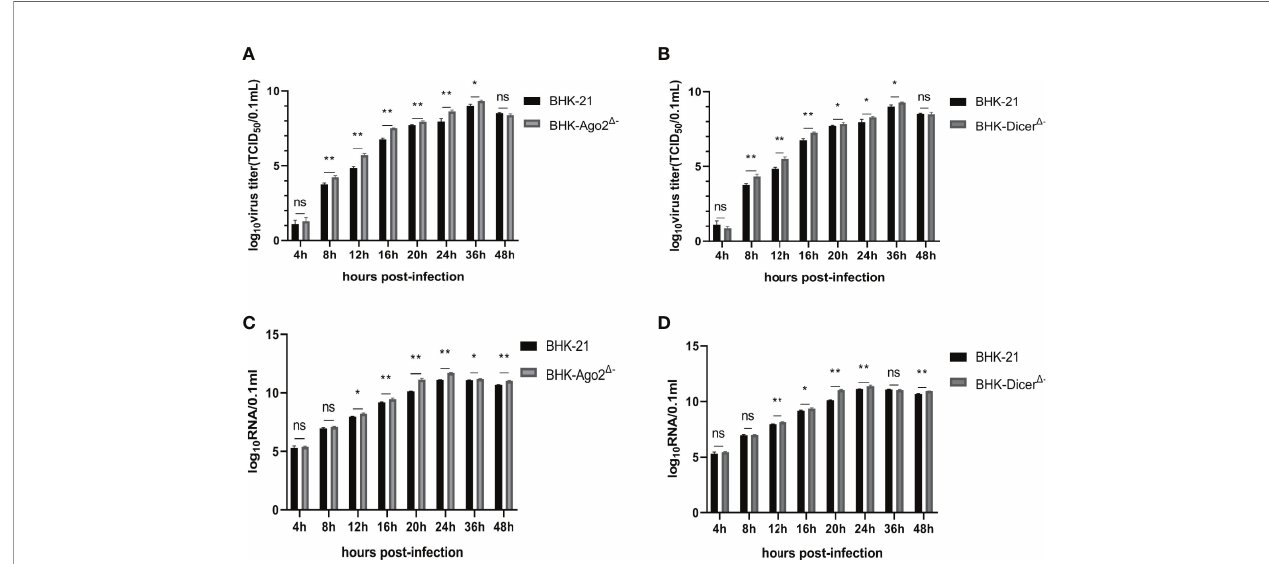
FIGURE 2 | Knockout cells promote the ability of SVA replication. (A, C) Replication ability of SVA in BHK-21 cells and BHK-Ago2 D - cells. The cells were infected with SVA with the SVA at MOI of 0.01. The viruses harvested at different times were titrated and expressed as TCID 50 , and the genome copy numbers were measured for the same samples by real-time reverse transcription-PCR (RT-PCR). Mean ± SD values are shown (repeated-measures ANOVA, n = 3; ns, no signi fi cant difference; * P < 0.05; ** P < 0.01). (B, D) Replication ability of SVA in BHK-21 cells and BHK-Dicer D - cells. The cells were infected with SVA with the SVA at MOI of 0.01. The viruses harvested at different times were titrated andexpressed as TCID 50 , andthe genome copy numberswere measured for the same samples byreal- time reverse transcription-PCR (RT-PCR). Mean ± SD values are shown (repeated-measures ANOVA, n = 3; ns, nosigni fi cant difference; * P < 0.05; ** P <